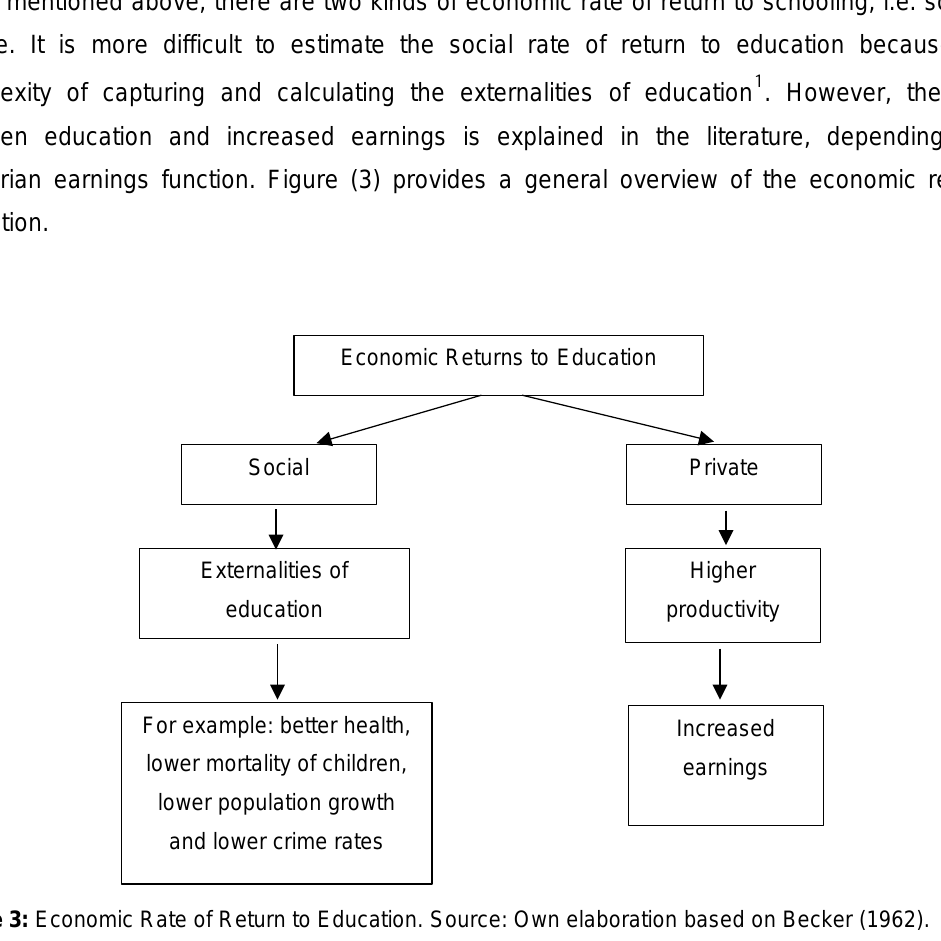
Figure 3: Economic Rate of Return to Education. Source: Own elaboration based on Becker